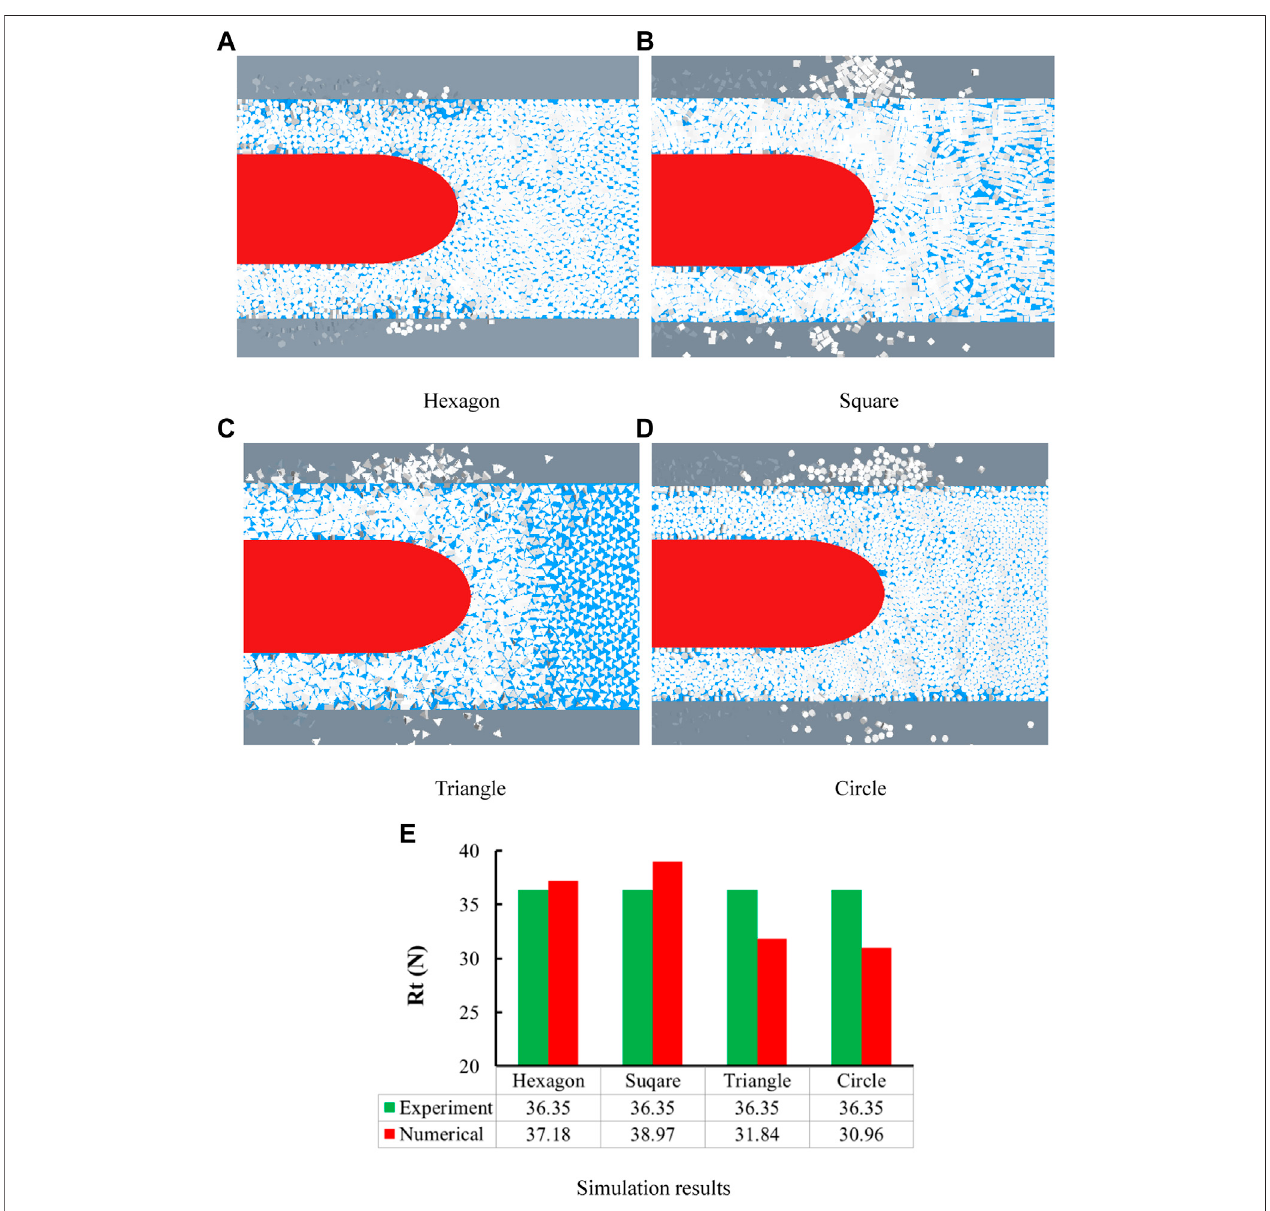
FIGURE 15 | Numerical simulations with different shapes of brash ice and